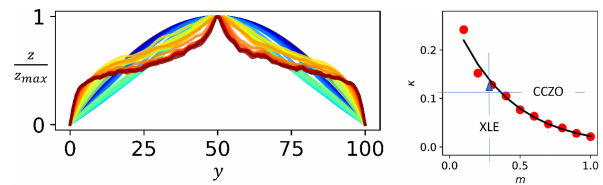
Figure 7. Mean elevation profiles for increasing values of C I (from blue to red lines) and, on the right, coefficient of the logarithmic profile as a function of the exponent m for simulations, the XLE laboratory experiments (Hooshyar et al., 2019), and the landscape at the Calhoun Critical Zone Observatory (CCZO). Modified after Hooshyar et al.